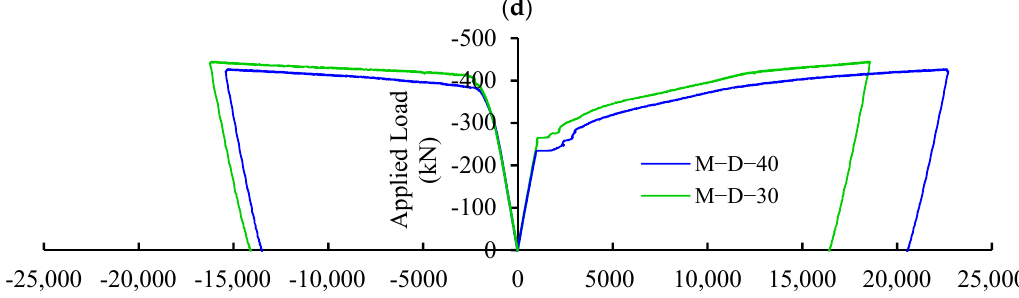
Figure 6. Applied load–strain response of specimens.